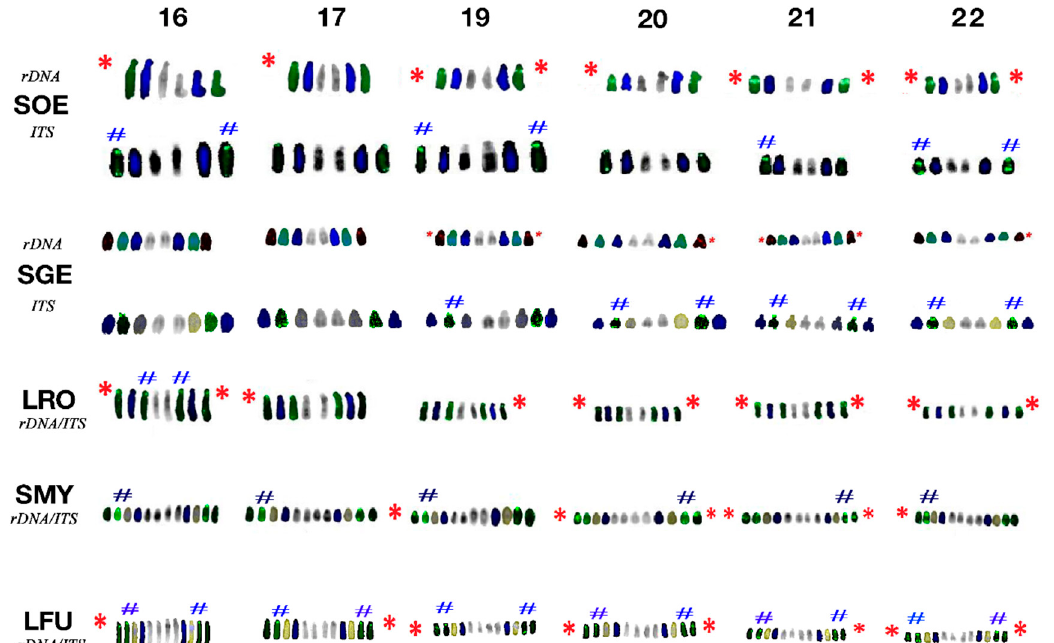
Figure 2. Chromosomes 16–17, 19–22 with rDNA and telomere loci mapping distribution for each species: Saguinus oedipus, Saguinus geoffroy , Leontopithecus rosalia , Saguinus mystax , Leontocebus fuscicollis . Each pair is reported covering the time when chromosomes were available after sequential DAPI, DAPI inverted, CMA3 staining and FISH mapping signals. Telomeric signals are in green, rDNA probes signals are in red except in SOE. The red stars label chromosomes with rDNA loci, the hash sign marks chromosomes with telomere probe amplification.